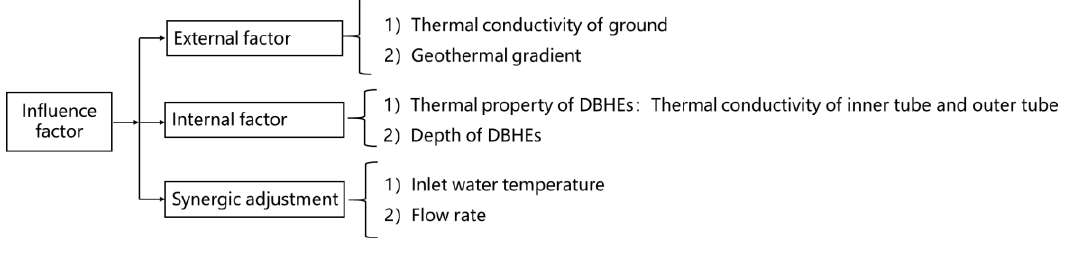
Figure 12. Influence factors of heat transfer